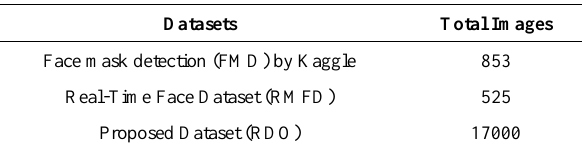
Table 1. Different